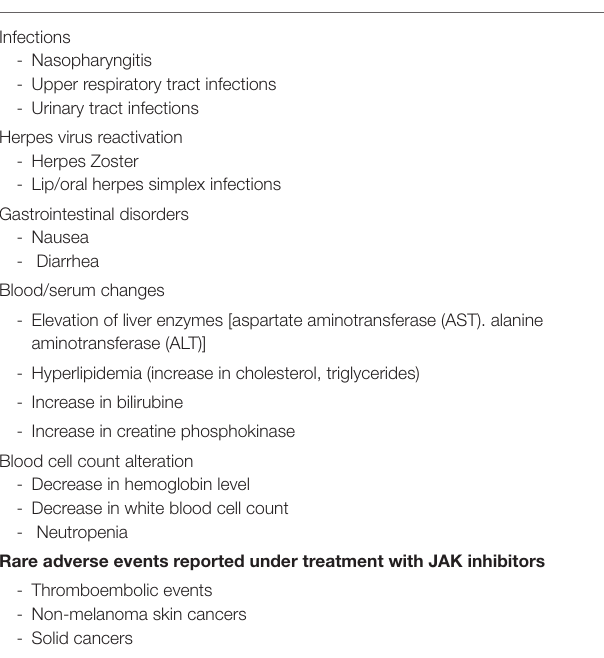
TABLE 1 | Selected adverse effects observed under treatment with JAK inhibitors. Frequent adverse events observed under treatment with JAK inhibitors Infections -